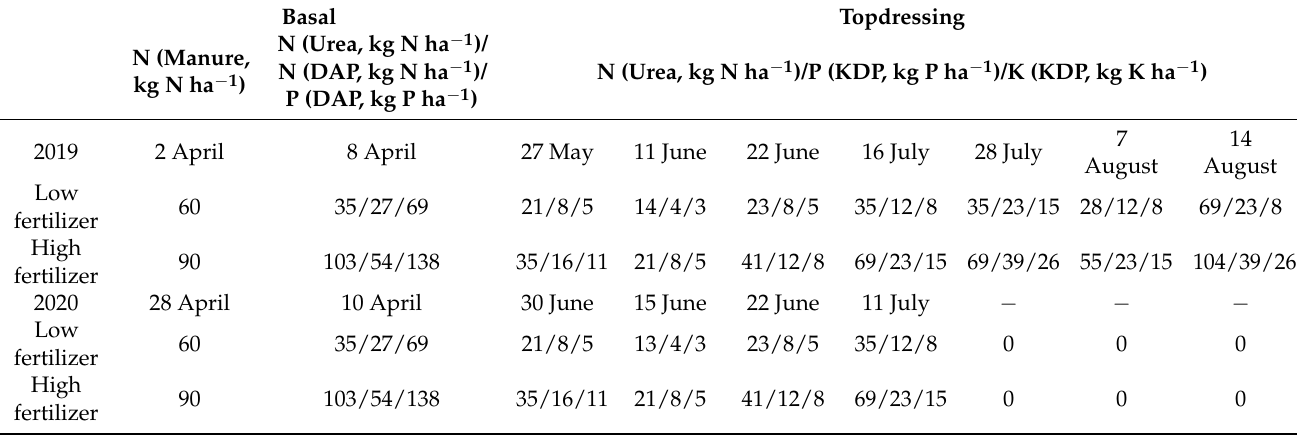
Table 2. Fertilization schedules for the low and high fertilizer treatments in 2019 and 2020. Basal